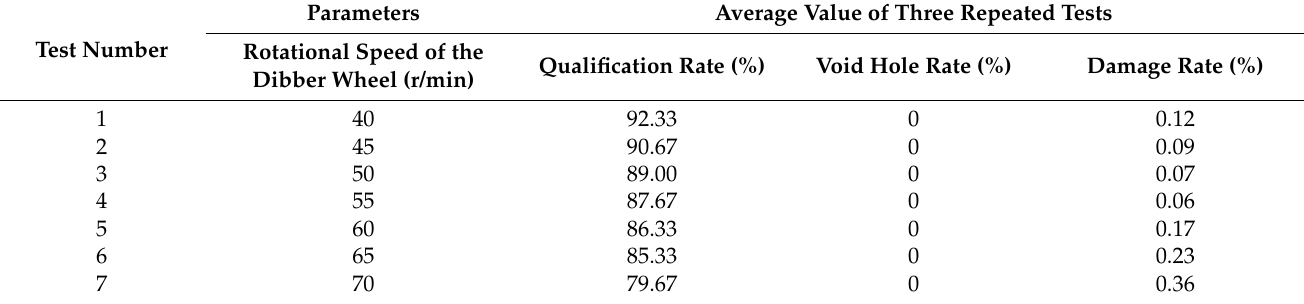
Table 6. Statistic of bench test